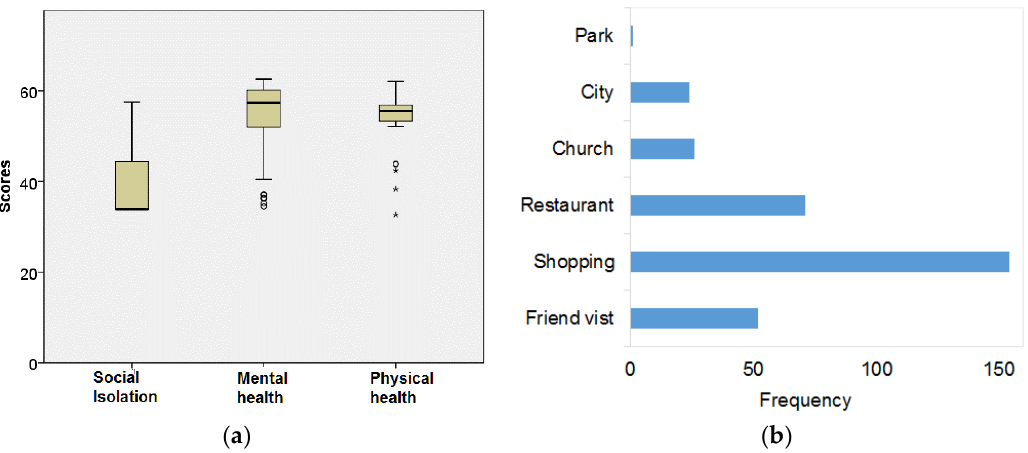
Figure 2. Statistical summary of surveyed data: ( a ) boxplot for three health scores of participants; and ( b ) reported frequency of visiting different types of locations.